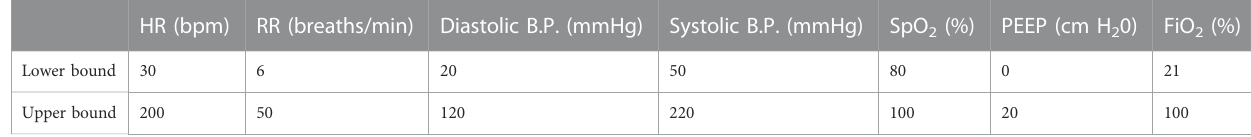
TABLE 1 Valid physiological vital signs parameter ranges to determine